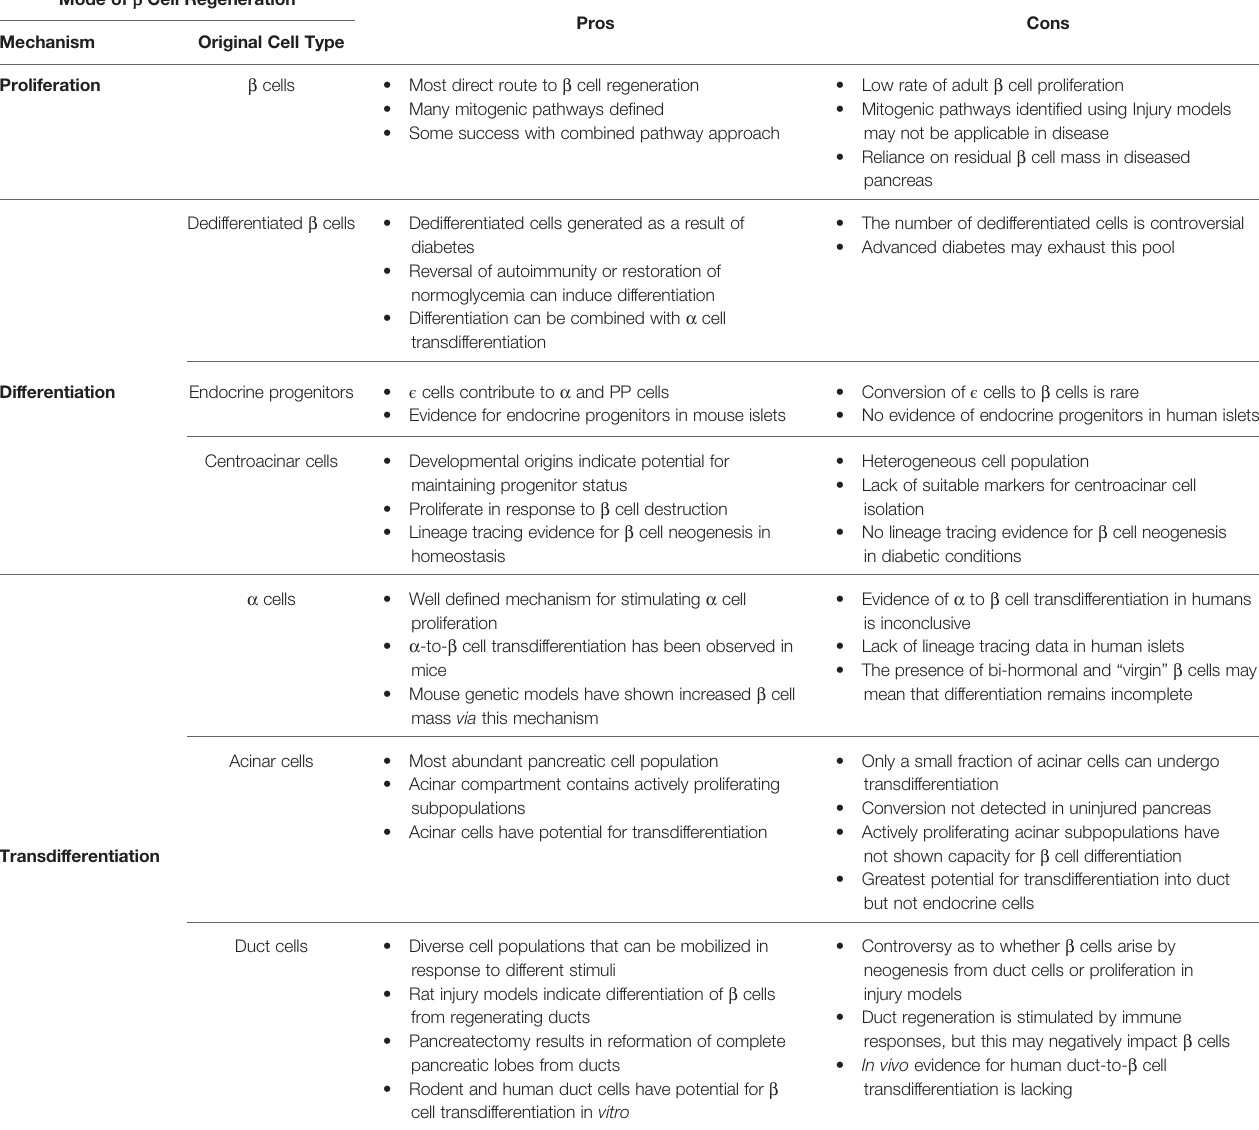
TABLE 1 | Pros and Cons of b cell proliferation versus neogenesis through progenitor differentiation or transdifferentiation. Mode of b Cell